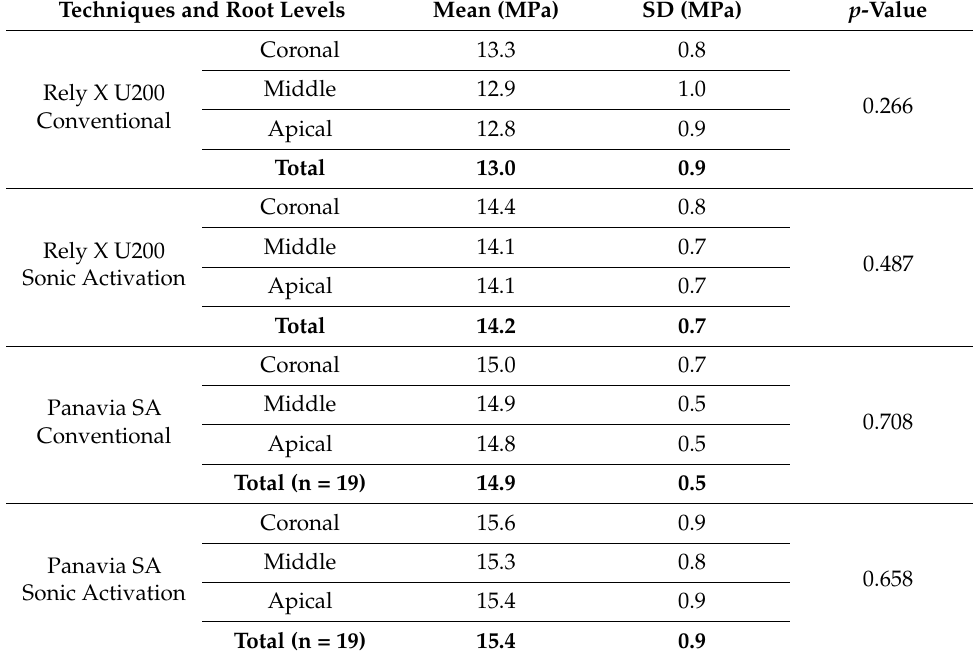
Table 2. Mean and Standard Deviation of different techniques at root levels.